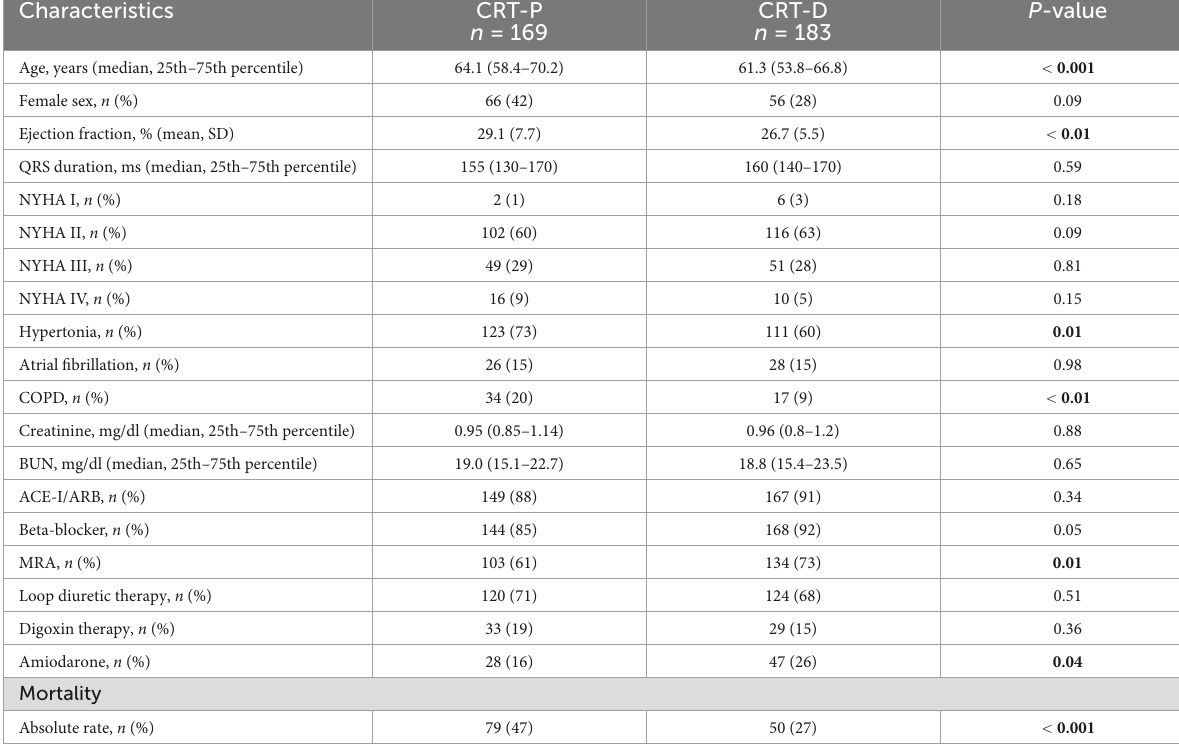
TABLE 2 Baseline characteristics of patients with Goldenberg risk score (GRS) <